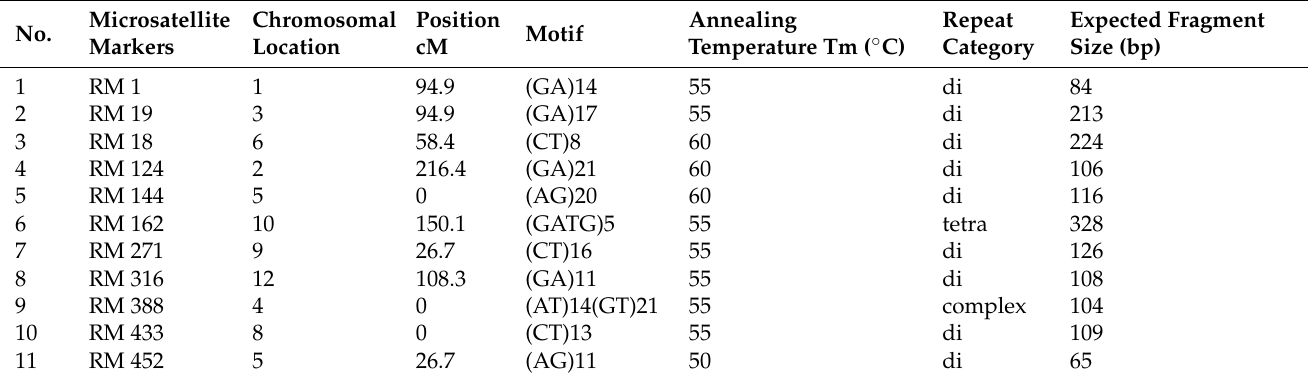
Table 6. Characteristics of 11 rice microsatellite (RM) markers, their chromosomal location, motif, annealing temperature, repeated category and fragment